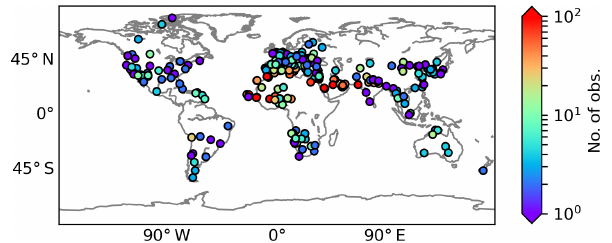
Figure B1. Global distribution of the OMAERUV–AERONET joint data set. The color indicates the number of observations. Note that all aerosol types are included.